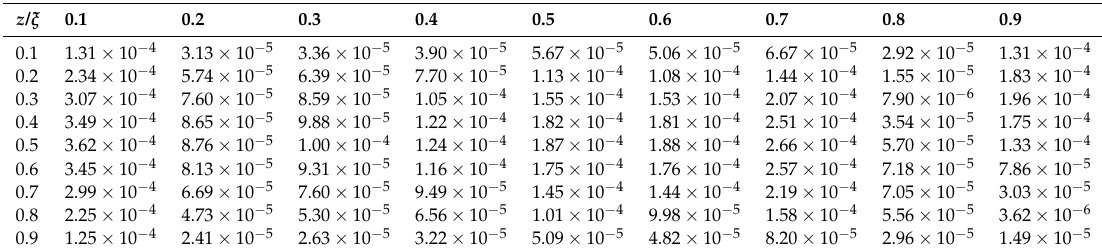
Table 2. Absolute error values of Example 1 for Burgers’ equation with α = 0.9.